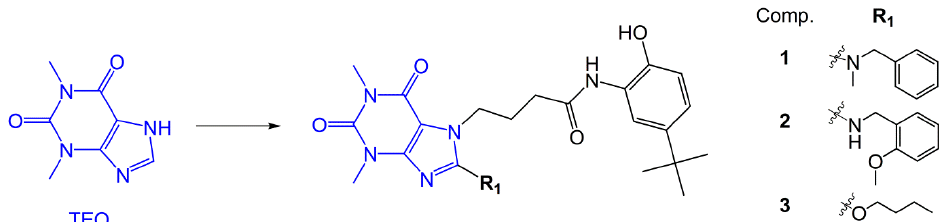
Figure 1. Chemical structures of study compounds: 1,3-dimethyl-3,7-dihydro-1 H -purine-2,6-dione (TEO) and 8-arylalkylamino ( 1 , 2 ) and 8-alkoxy ( 3 ) derivatives of 1,3-dimethyl-2,6-dioxo-1,2,3,6-tetrahydro-7 H -purin-7-yl- N -(5-( tert -butyl)-2-hydroxyphenyl)butanamide.